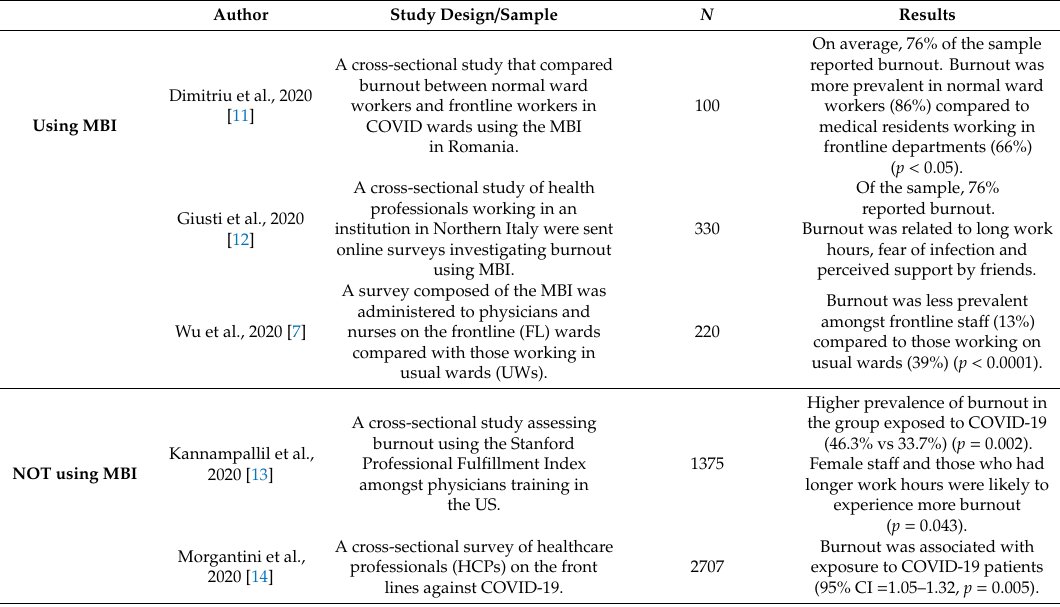
Table 3. Methodological characteristics and the main results for studies prior to COVID-19 on potential factors contributing to burnout.